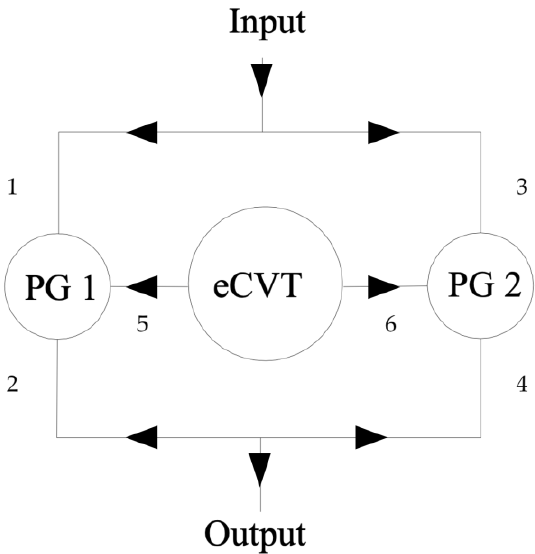
Figure 2. Shafts indexing with positive direction of power on all shafts.